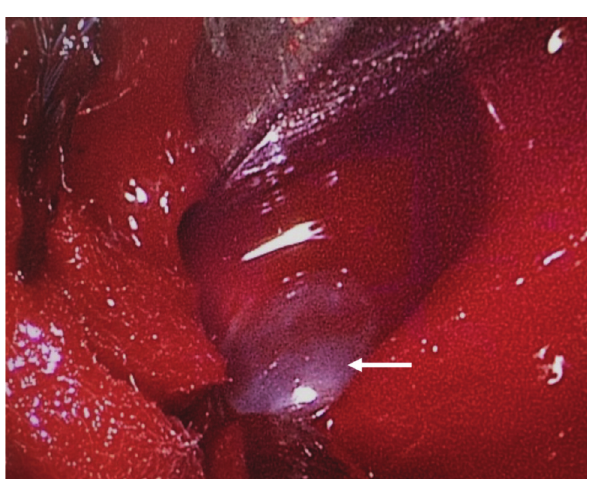
Sagittal view of the lumbar spine MRI showing a cystic Fig. 1: lesion in the anterior epidural space with high signal intensity on T2-weighted image.